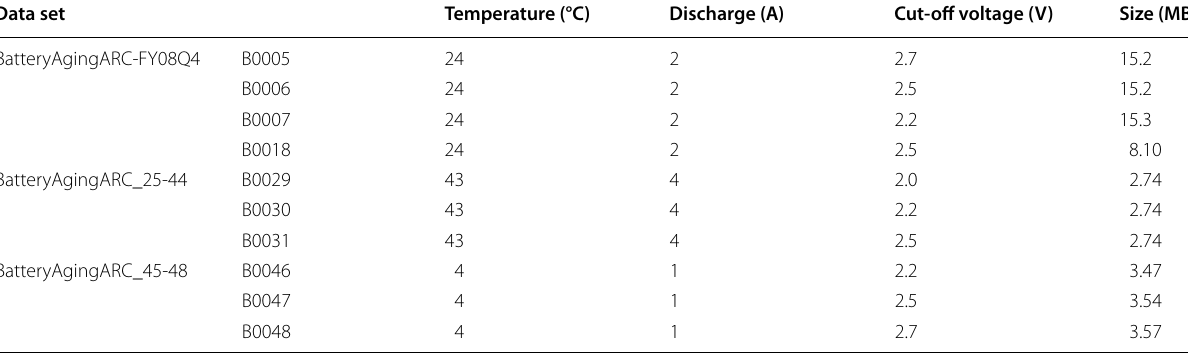
Table 1 Details of the selected dataset Data